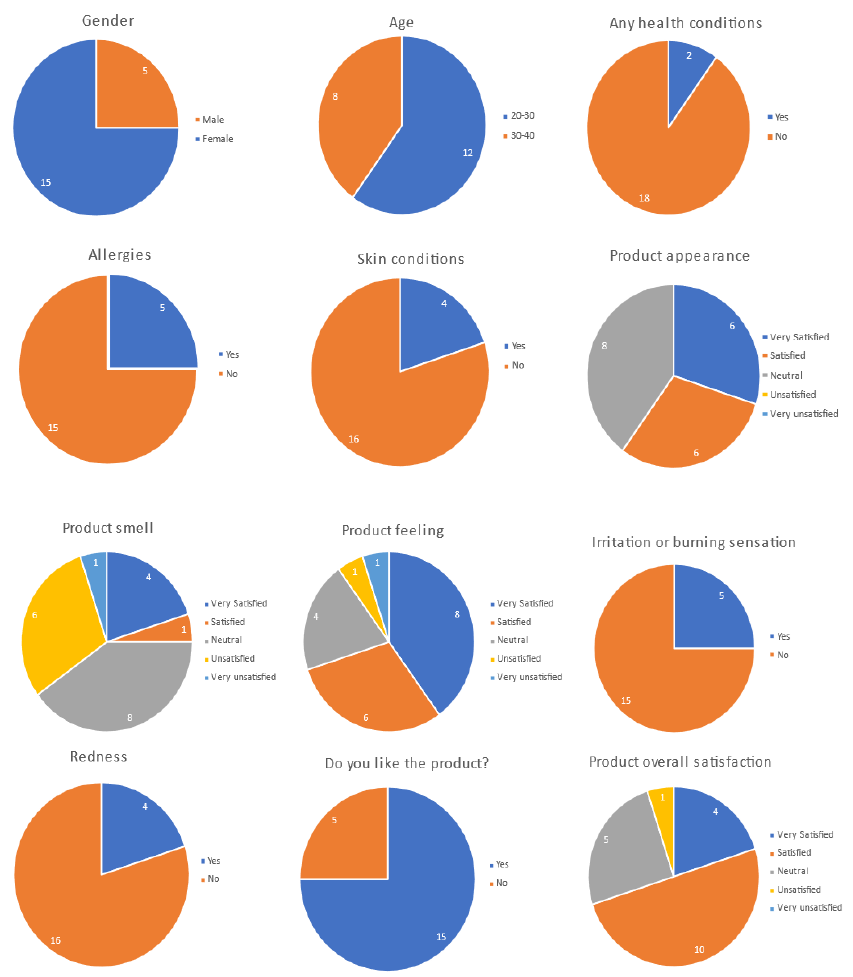
Figure A1. The results of the questionnaire that was provided to the 20 volunteers to conduct the acceptability test and skin irritation